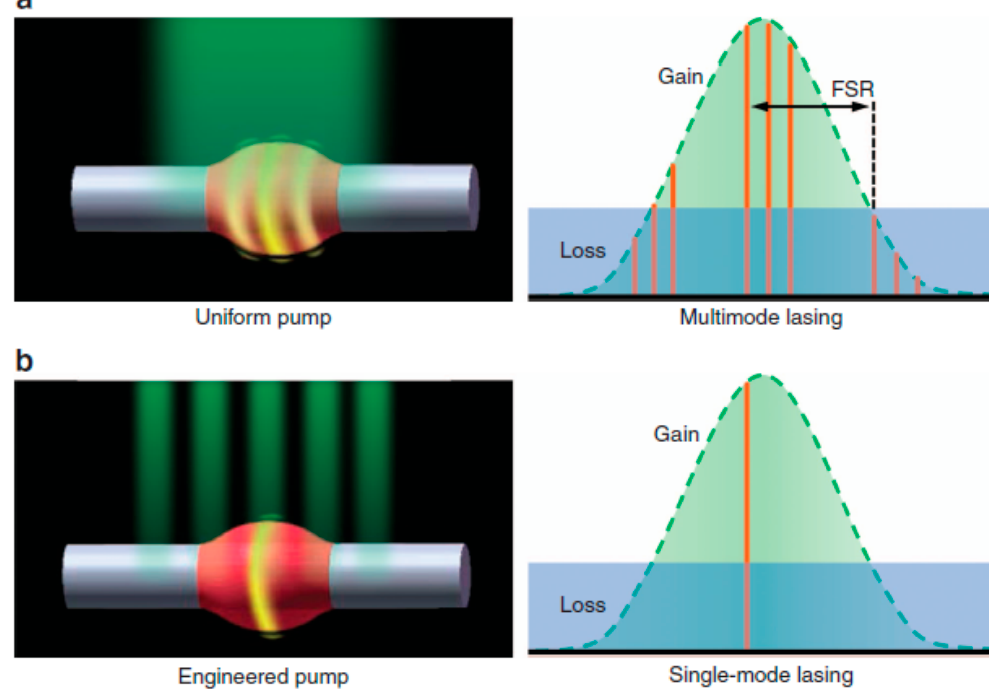
Figure 7. WGM dye laser based on the microbottle structure. ( a ) Uniform pump and multimode lasing; ( b ) modulation pumping and single mode lasing [42].